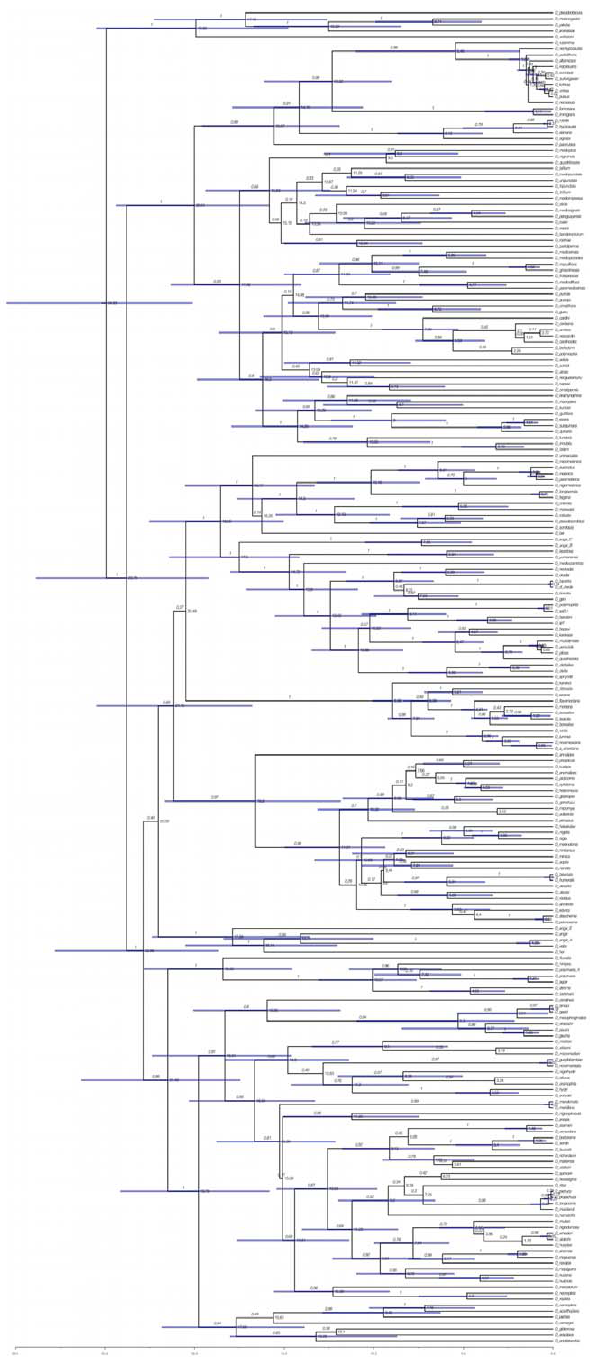
Figure 3. Summarized chronogram for the subgenus Drosophila obtained with BEAST using 218 species and 5 calibration points. Numbers on nodes indicate ages for the corresponding nodes; numbers on branches indicate BPP values. Bars represent the 95% highest posterior density (HPD) interval for the divergence times.